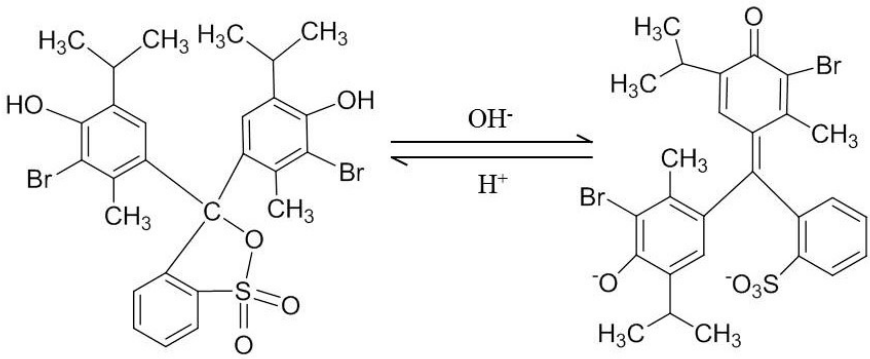
Figure 1. Structural changes of bromothymol blue in acid and alkaline solutions.